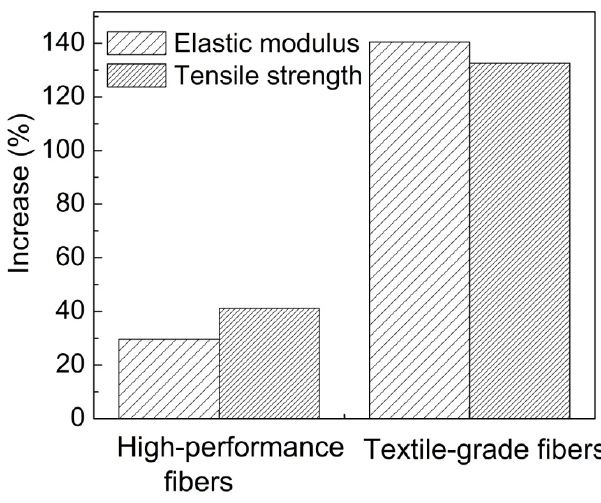
Figure 4. Average percent increase comparison between control fibers (no fillers) and composite fibers for both the Young’s modulus and tensile strength properties. The graph compares the differences in percent increase for the high-performance and textile-grade polymeric fiber materials